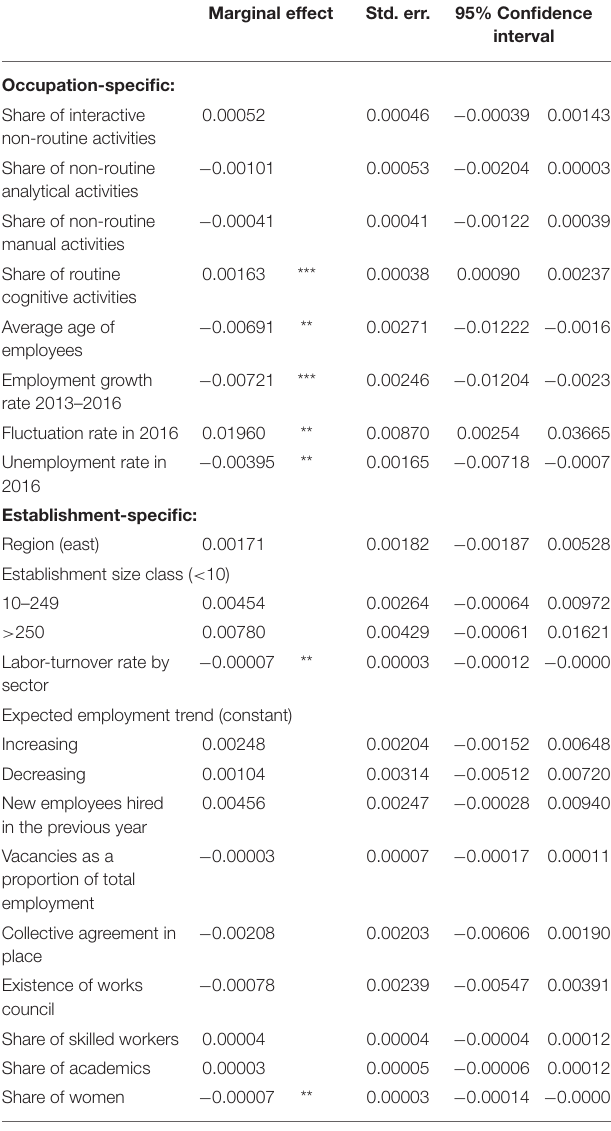
TABLE 10 | Marginal effects: increasing requirements regarding self-organization. Marginal effect Std. err. 95% Confidence